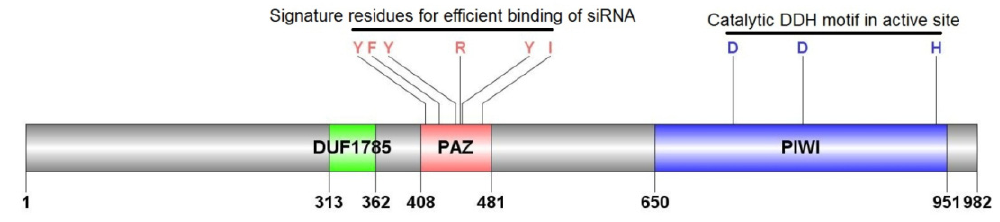
Figure 3. Ago2 protein in A. glycines . AyAgo2 is 982 amino acids in length. The relative positions of three domains (domain of unknown function (DUF1785), PAZ, and PIWI) are